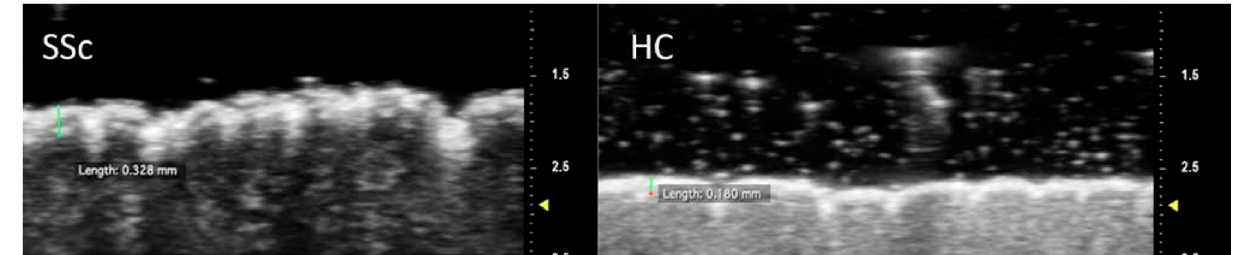
Figure 2. Measurement of epidermal thickness at the intermediate phalanx of the second finger. Note the increased thickness of the epidermal layer in the SSc patient compared to the control subject.